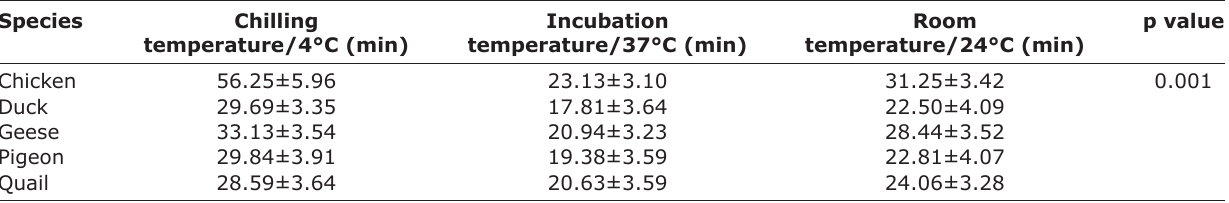
Table-2: Time required for HA of avian RBC with VVNDV (field isolate) at different temperatures (mean±SD). Species